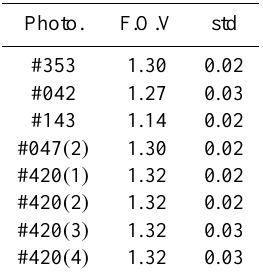
Table 6. Values of the field of view (in degrees) calculated during the preliminary tests using the Sun as a light source.